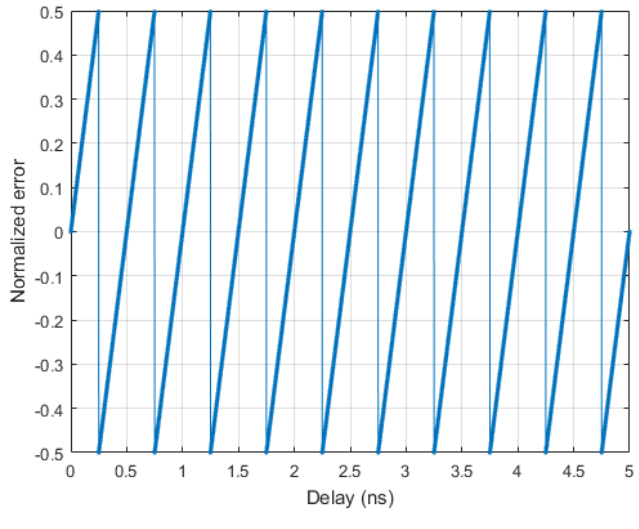
Figure 7. Normalized quantization